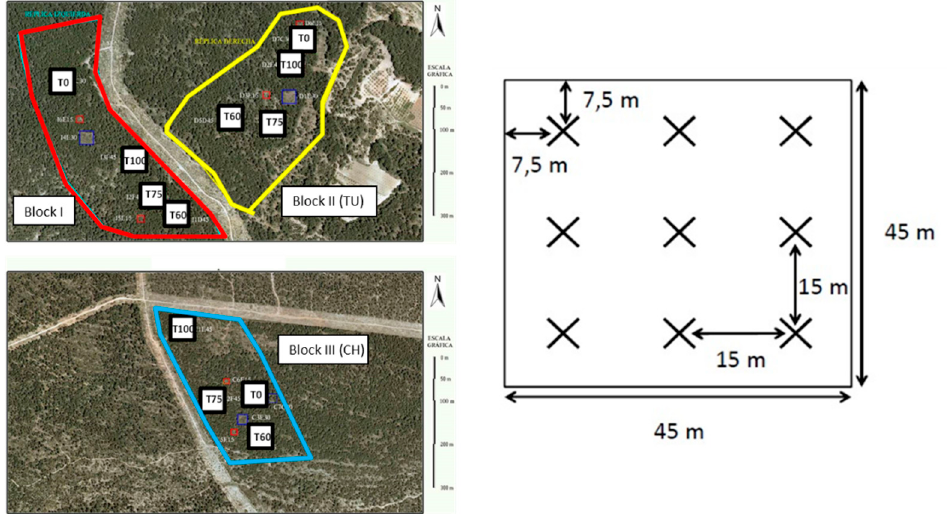
Figure 1. Spatial distribution of silvicultural treatments in each block and distribution of points selected for nitrogen mineralization in each plot with the perimeter treatment area included.